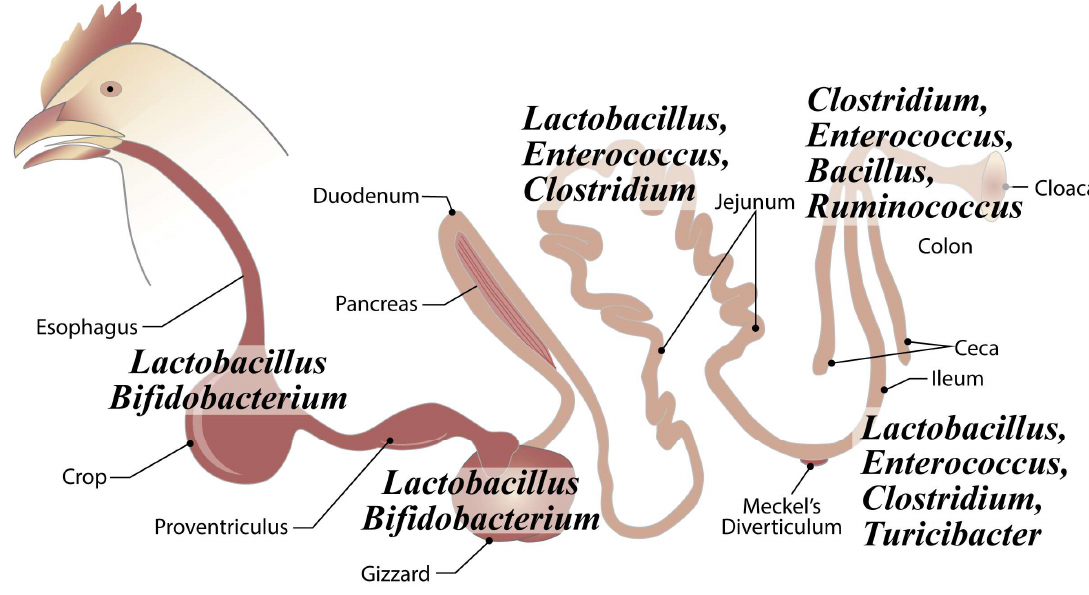
Figure 2. Chicken intestinal communities di ff erentiate along the intestinal tract. The most abundant bacterial taxa are indicated for each gut compartment.